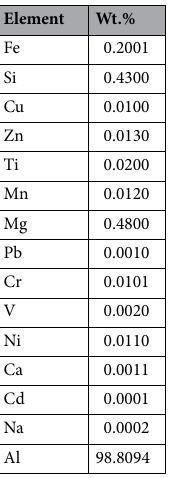
Table 1. Elemental composition of Al–Mg-Si alloy.